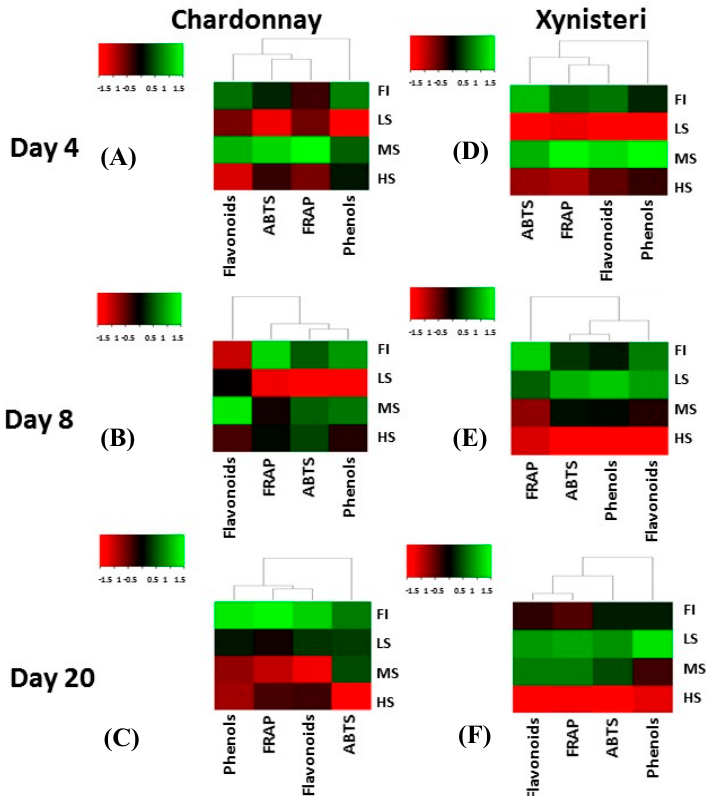
Figure 5. Relative changes in total phenols, flavonoids and antioxidant activity (FRAP, ABTS) after exposure of grapevine cultivars, Chardonnay ( A,B,C ) and Xynisteri ( D,E,F), to water and heat stress. Heat map representing relative composition level of molecule traits after 4, 8 and 20 d of light water stress (LS) with 80% of the FI, moderate water stress (MS) with 50% of the FI, and heat stress (HS) as compared to control (full irrigation, FI) plants. Red shades indicate the lower level (less than − 1.5 fold), deep red corresponds to − 1 fold, black signifies that the level is not different from the control, deep green corresponds to 1 fold, clear green indicates that the level is more than 1.5-fold higher than the control. Total phenols are expressed as GAE g − 1 , flavonoids in mg rutin g − 1 and FRAP and ABTS in mg trolox g − 1 .